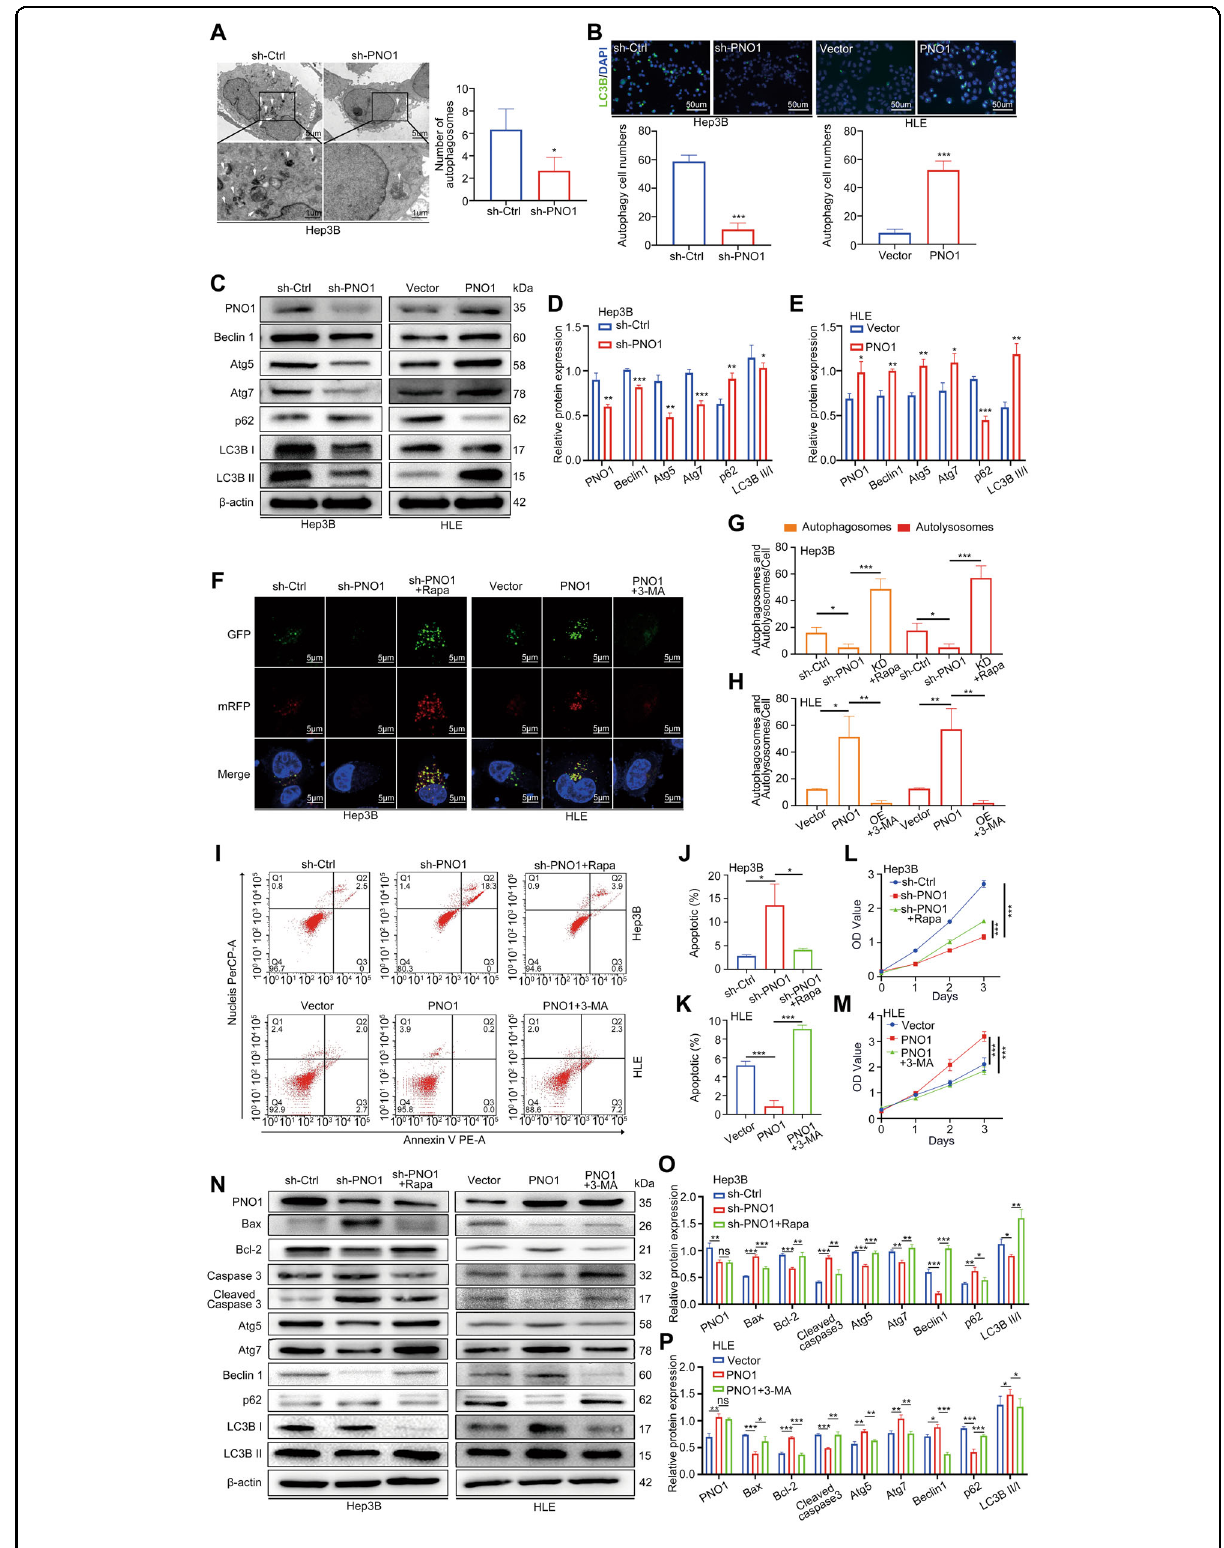
Fig. 3 (See legend on next